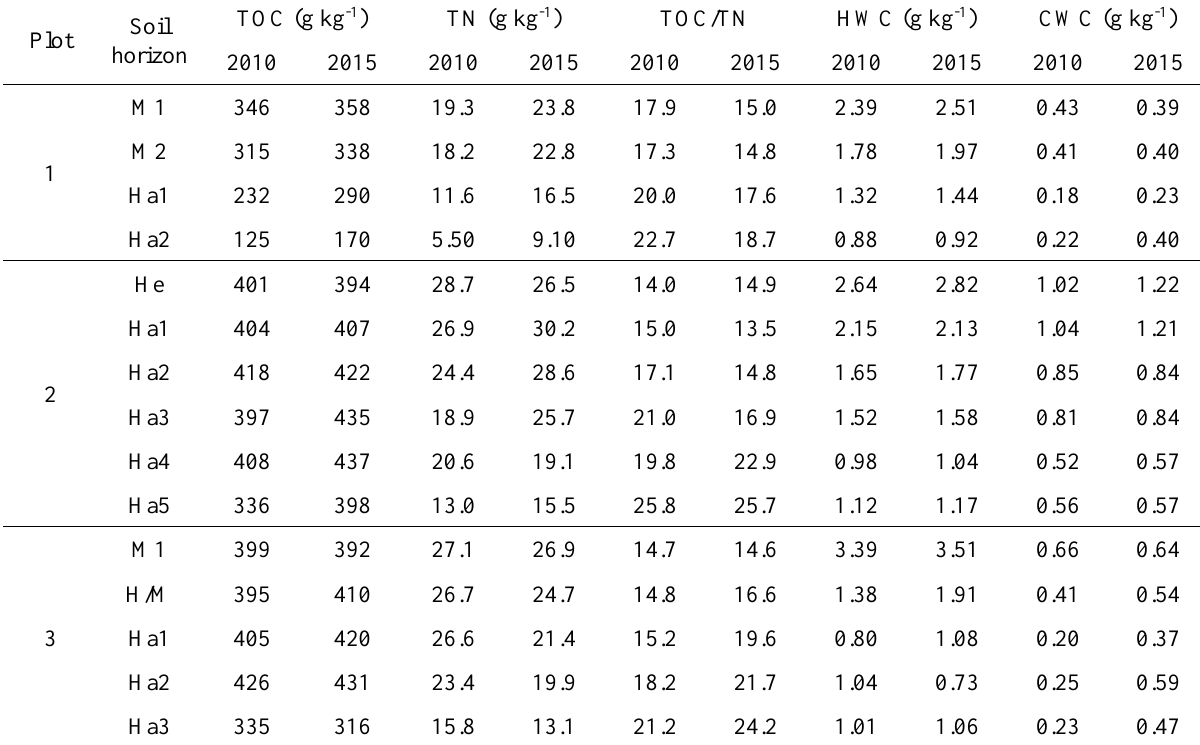
Table A3. Soil chemical properties (mean values). Soil Plot